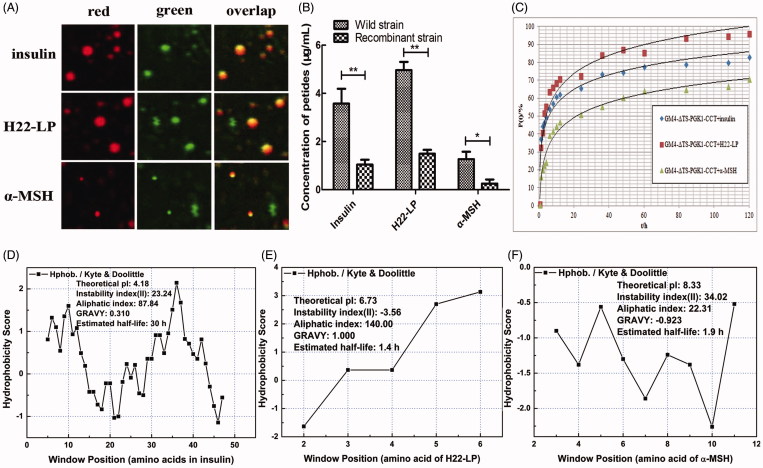
Effects of the exogenous polypeptide drugs transfected into the recombinant strains. (A) Analysis of the location of FITC-F-insulin, FITC-F-H22-LP, and FITC-F-α-MSH by CLSM and staining the lipid droplets with the Nile Red dye. The red fluorescent channel, green fluorescent channel, and an overlap of the red and green fluorescent images are shown. (B) The polypeptide contents of the exogenous polypeptide in the cell by electrotransformation. *p ˂ .05 and **p ˂ .01 compared with the wild-type strains. (C) The relationship between drug release rate P(t) and the time when the recombinant strain carried different exogenous polypeptides in PBS buffer. (D, E, and F) are based on the amino acid sequence of the polypeptide. The ProtScale software was used to predict the hydrophobicity of insulin, H22-LP, and α-MSH, and then the Protparam software was used to predict the theoretical pI, instability index, aliphatic index, and GRAVY of the proteins for further verification.